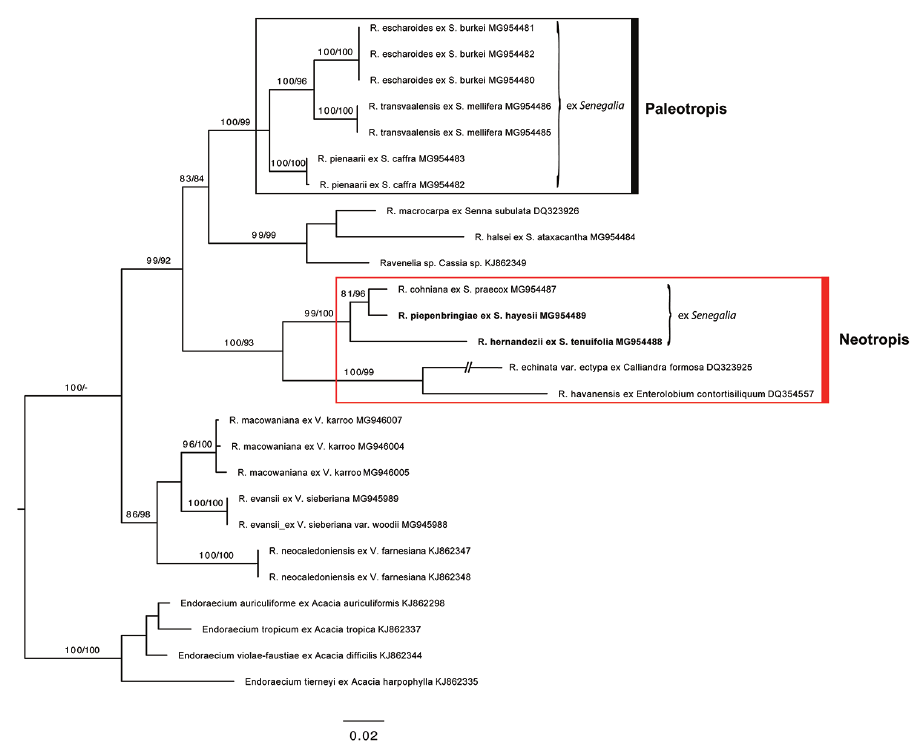
Figure 1. Maximum likelihood reconstruction of Ravenelia spp. based on 28S rDNA sequence data. Bootstrap values are shown above branches based on 1000 replicates (MLBS and MPBS, respectively), values below 75 are not shown. Names of species collected on neotropical Senegalia hosts including R. piepenbringiae and R. hernandezii are highlighted (bold, red box). For paleotropically distributed species of Senegalia rusts, see black